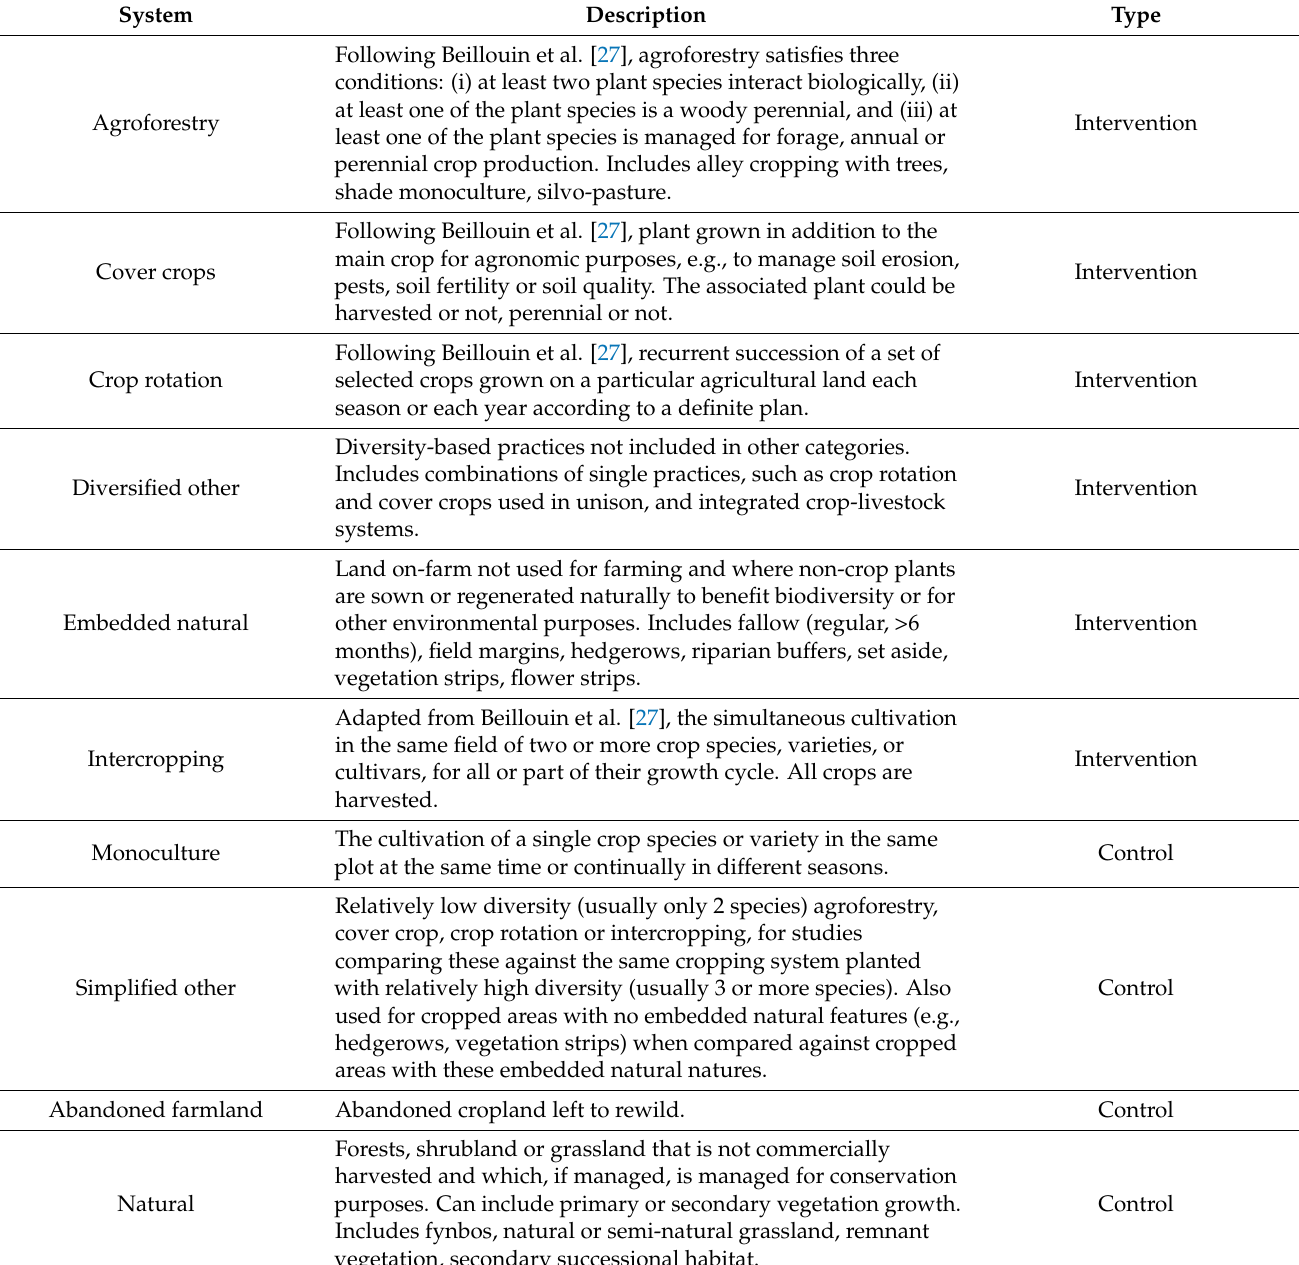
Table 2. Control and intervention systems